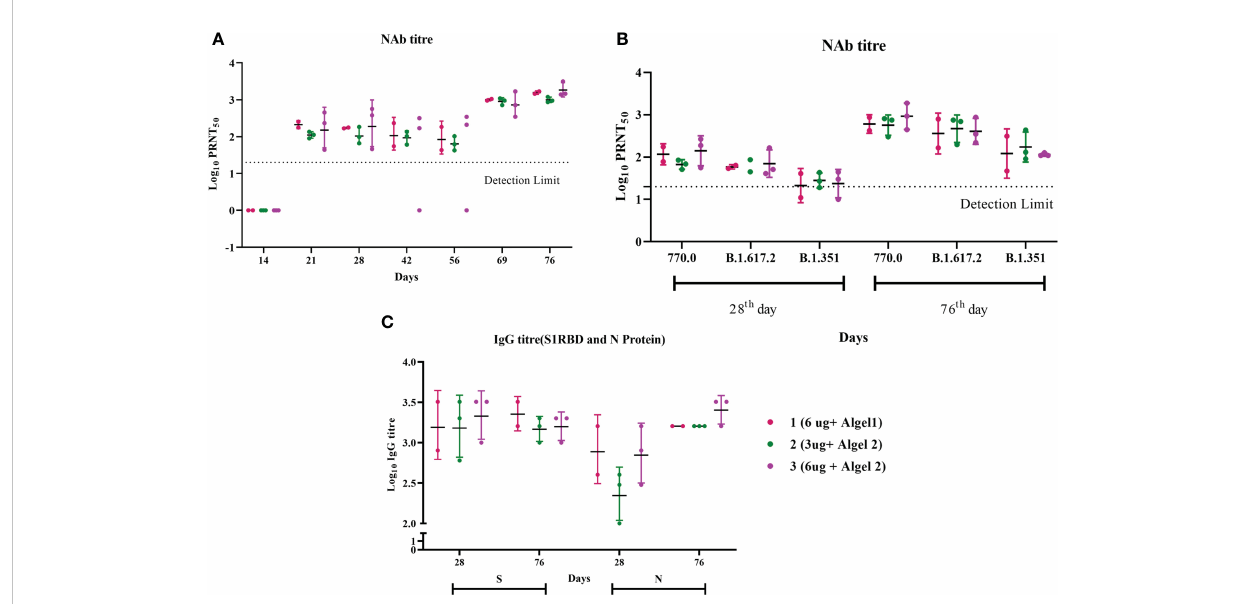
FIGURE 1 Antibody responses in vaccinated aged rhesus macaques. (A) Neutralizing antibody responses against the SARS-CoV-2 B.1 variant on different time points. (B) Neutralizing antibody responses against SARS-CoV-2 variants, B.1, delta, and beta on days 28 and 76. (C) S1-RBD and N protein IgG antibody response during the immunization with group 1, 2, and 3